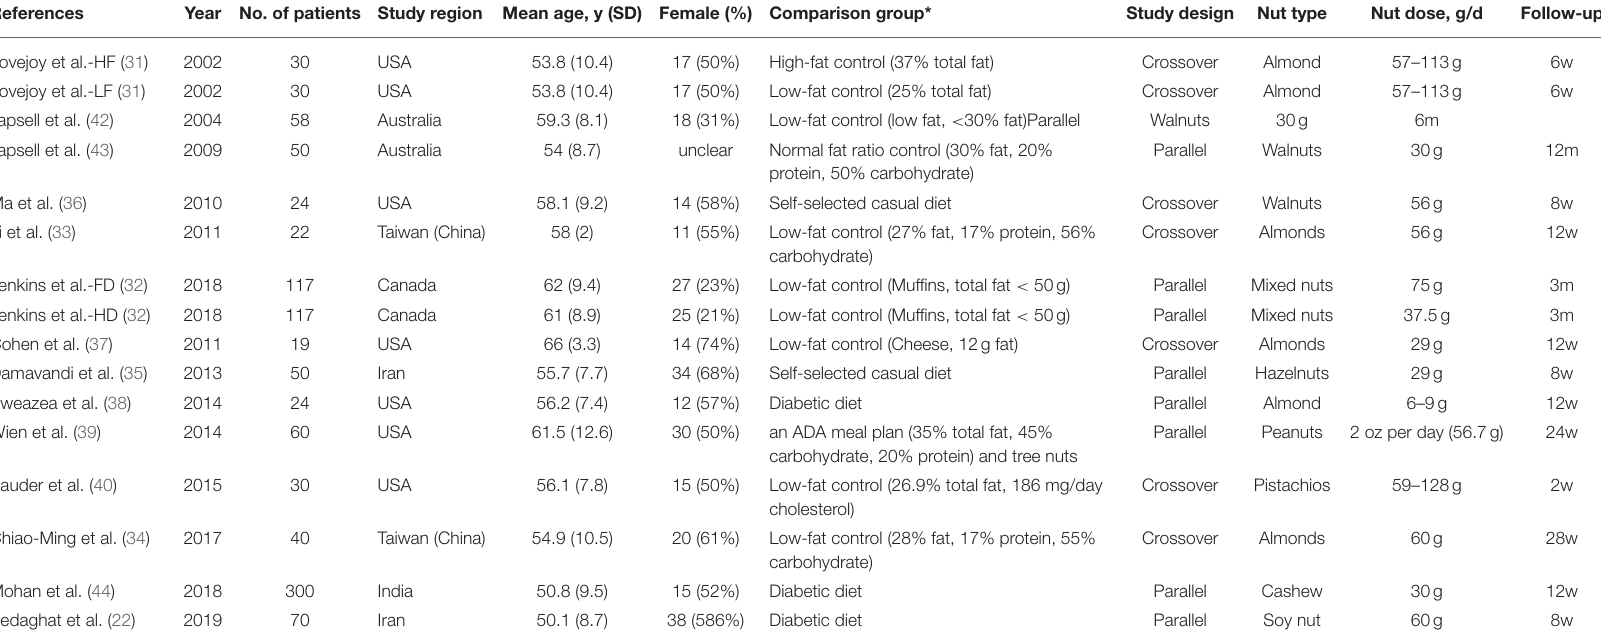
TABLE 1 | Characteristics of included 16 trials in the systematic review and meta-analysis (mean values and standard